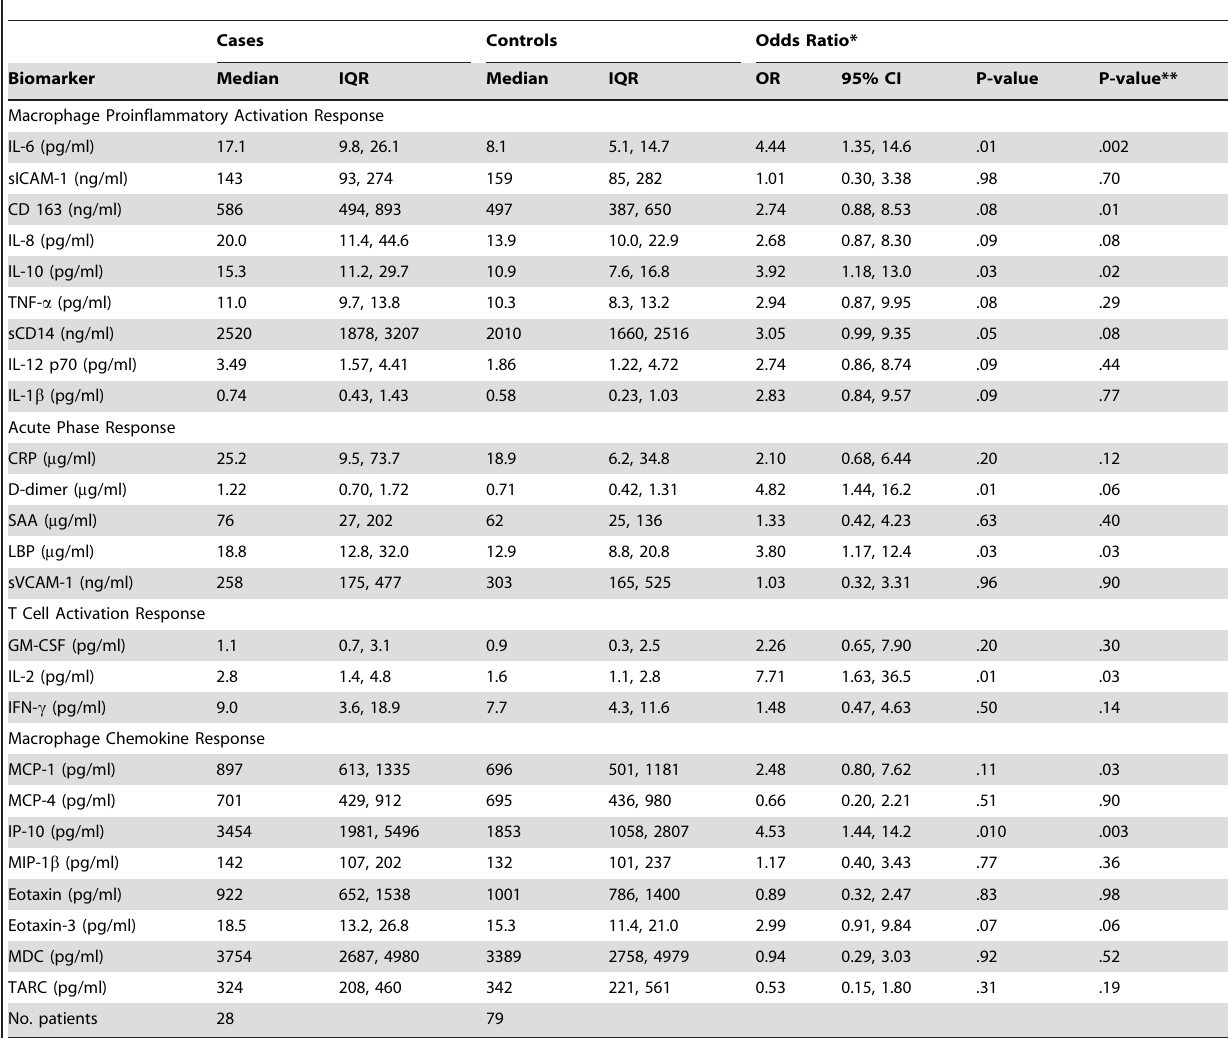
Table 4. FLU 002 Patients: Odds Ratios of Progression for the Highest Versus Lowest Tertile of Each